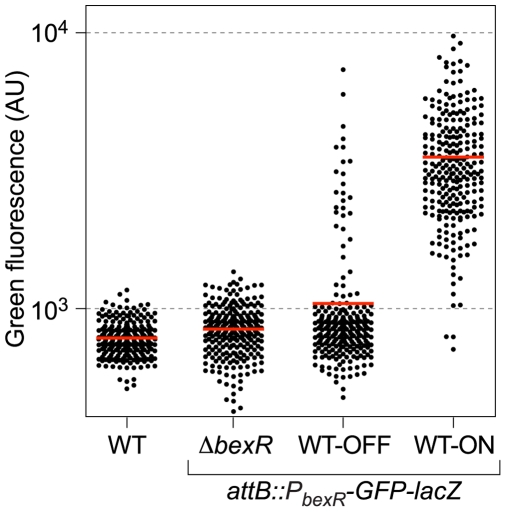
Automated fluorescence intensity measurement of single cells reveals bistable expression from the bexR promoter.Cultures of wild-type PAO1 (WT), the wild-type attB::PbexR-GFP-lacZ fluorescent reporter strain (originating from ON and OFF colonies) and the ΔbexR attB::PbexR-GFP-lacZ fluorescent reporter strain (see Figure 1D), were grown and examined and measured for fluorescence upon reaching mid-logarithmic phase by fluorescence microscopy. Black dots correspond to the automatically measured fluorescence intensity of individual cells (in arbitrary units, AU) in a sample size of 250 cells. The red bar represents the mean fluorescence intensity of cells in a sample.